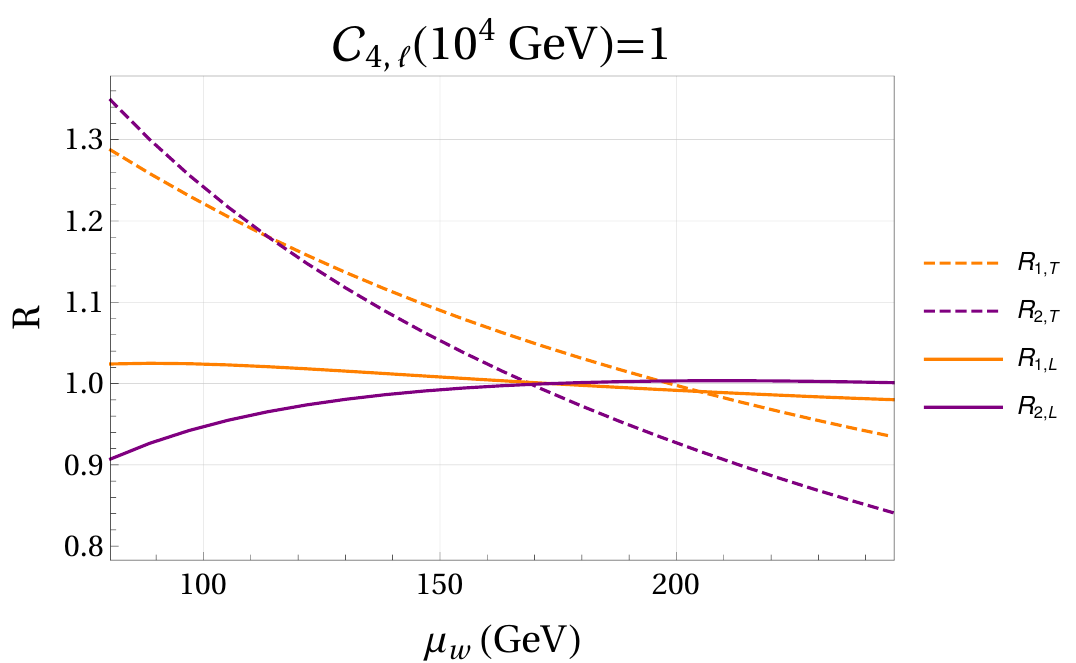
Figure 3 . Ratios of matching conditions as function of the matching scale below EWSB µ W for fixed Λ = 10 4 GeV and C 4 ,‘ (Λ) = 1 as the initial condition for the